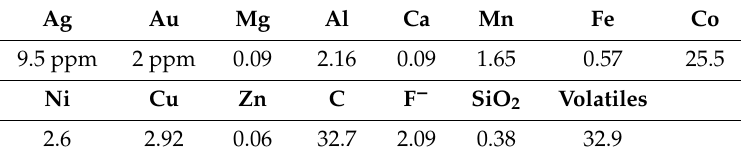
Table 2. Composition of the recycled battery scrap in wt% (except Ag and Au in ppmw). Ag Au